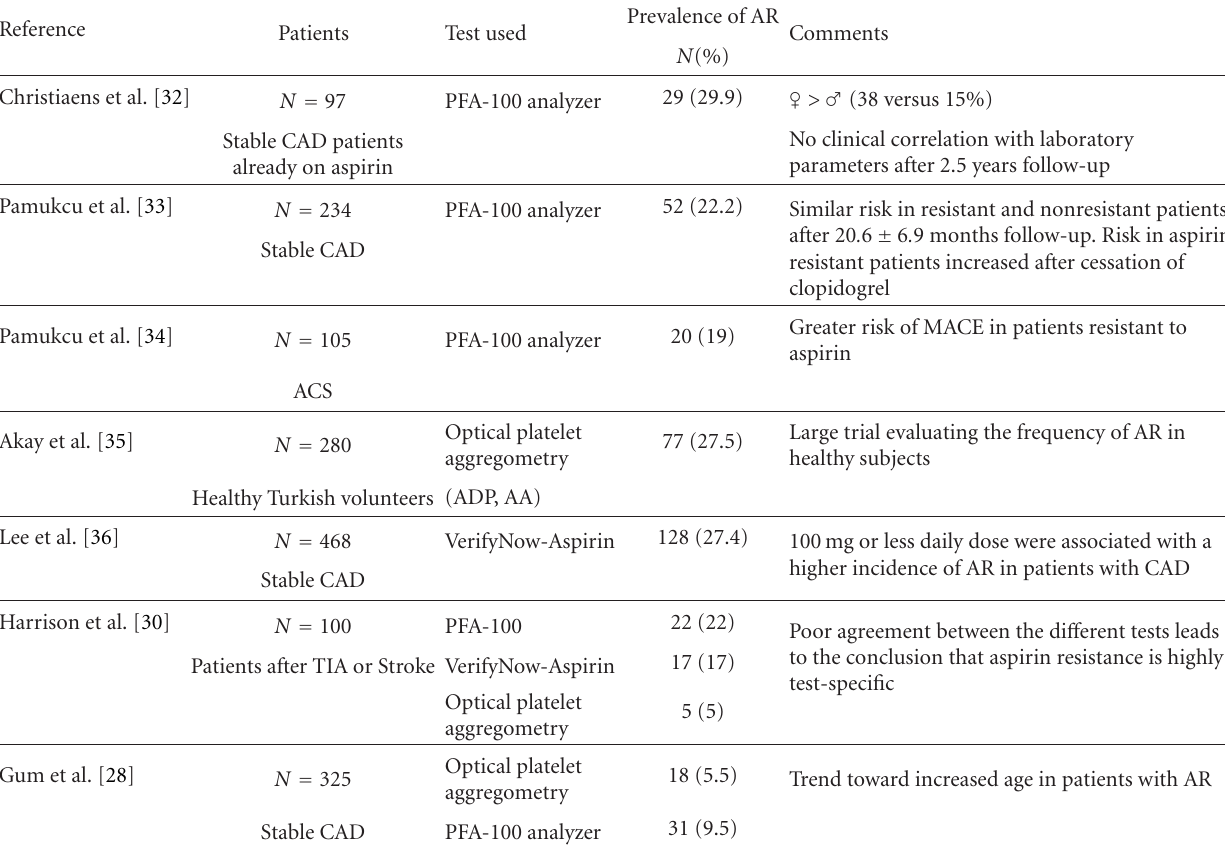
Table 1: Prevalence of aspirin